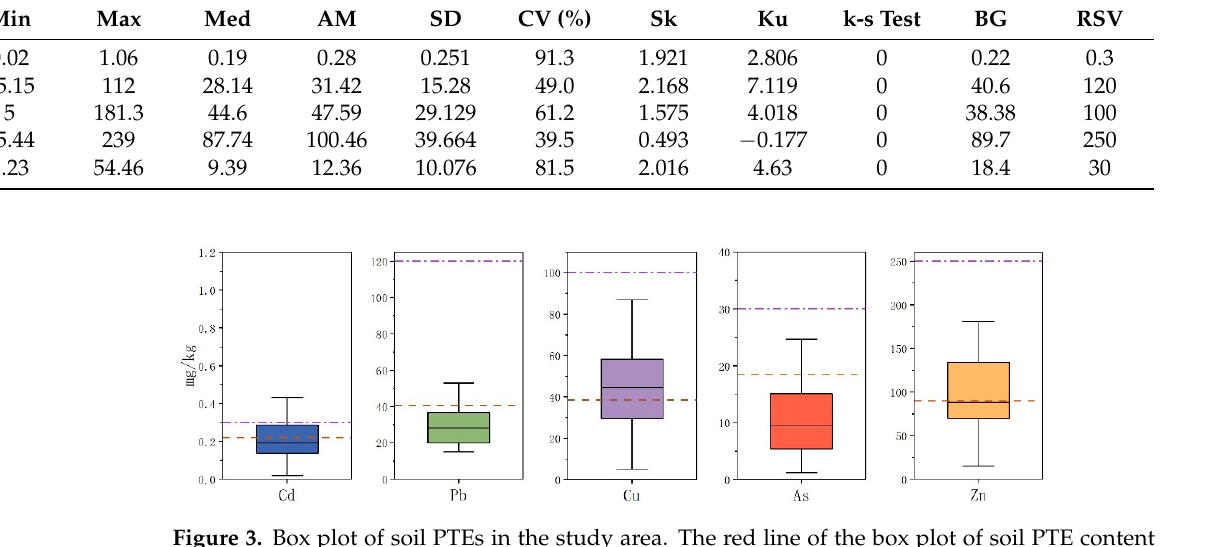
Figure 3. Box plot of soil PTEs in the study area. The red line of the box plot of soil PTE content represents the background value, and the purple line represents the risk screening value.